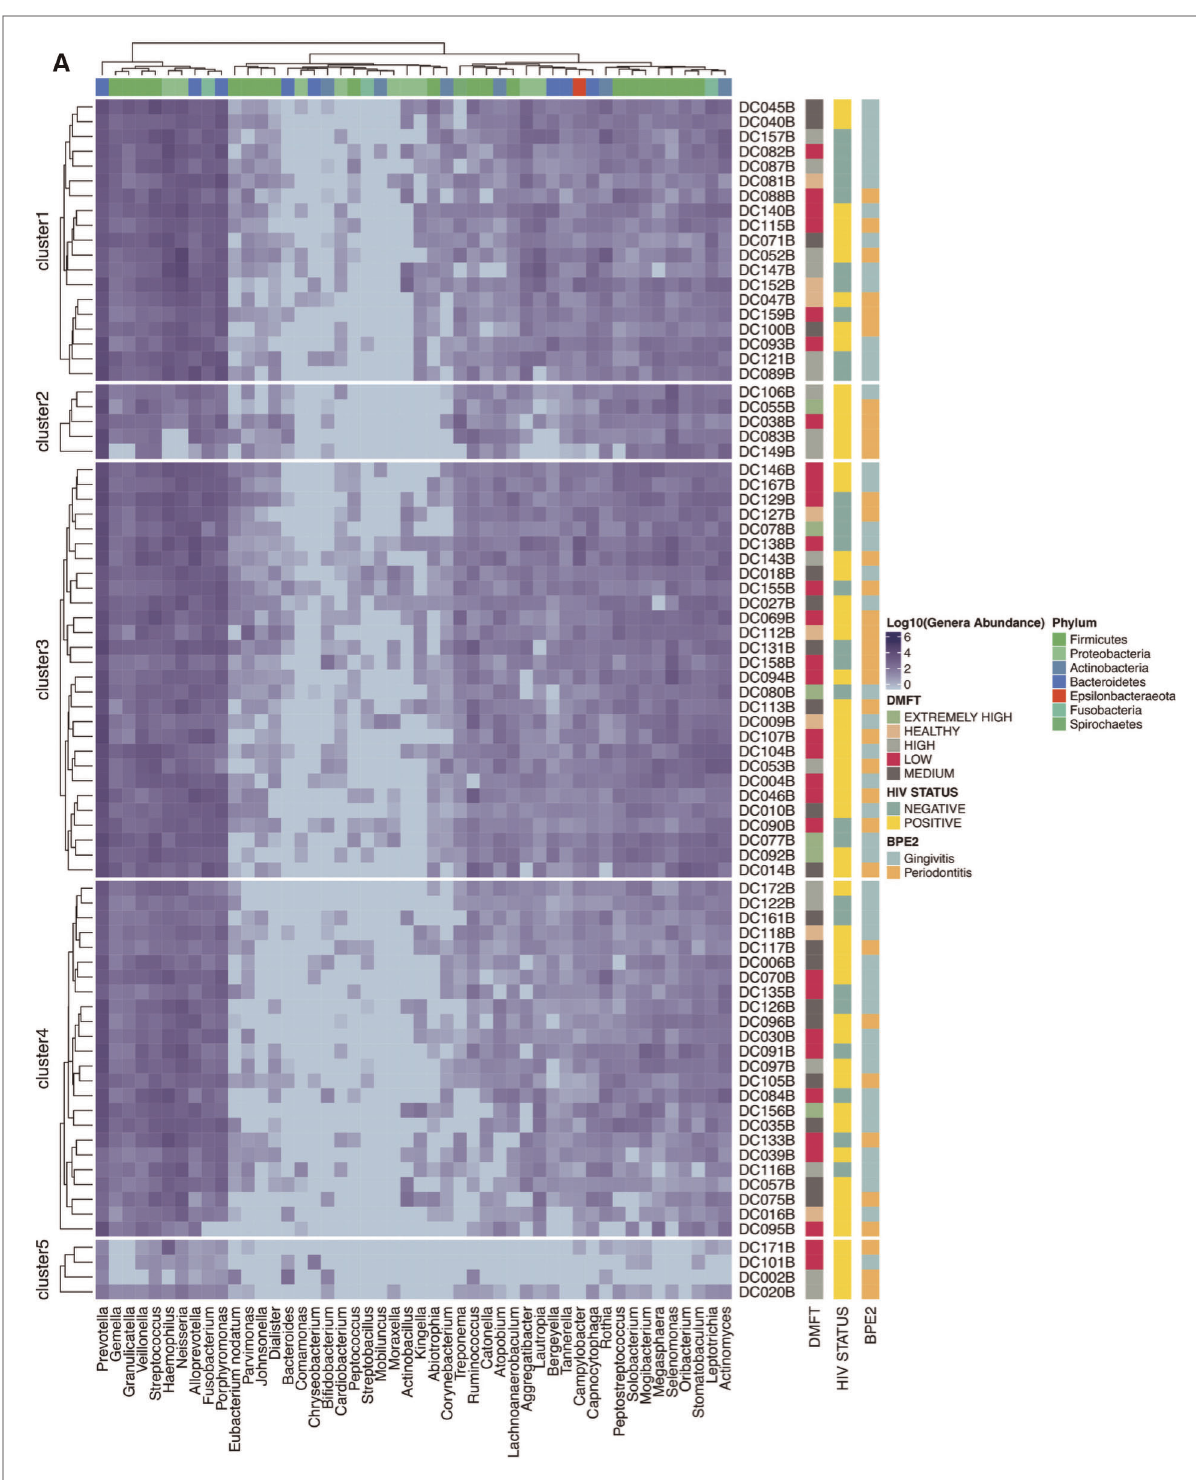
FIGURE 3 Shows the different microbial components tracked along the DMFT. Panel ( A ) is the DMFT core, which is the genera present at all stages of the DMFT, Panel ( B ) shows the genera previously associated with oral disease characterized by patient ID, HIV status and type of oral disease. Panel ( C ) shows the different proportions of microbial groups along the DMFT